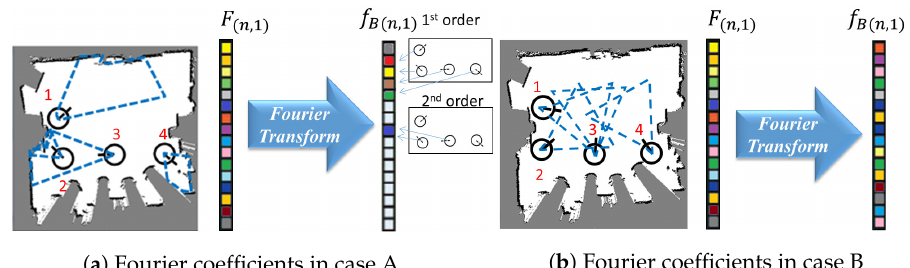
Figure 4. Illustration of the sparsity of submodular functions in the Fourier domain. The black and white areas are obstacles and unoccupied grids, respectively. The black circles and lines represent the robot position and heading, respectively. The blue dash lines are the covering area of the corresponding robot position. The colorful and white cells in the bars represent non-zero and zero values,